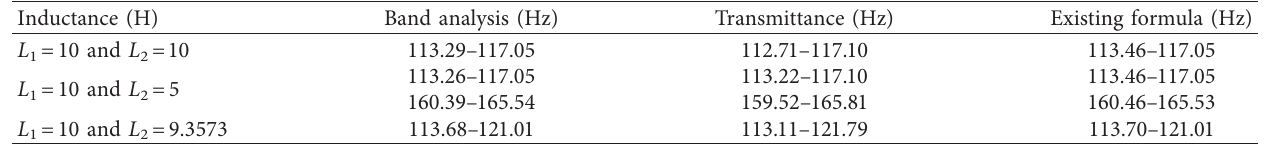
Table 2: Comparisons of the bandgap